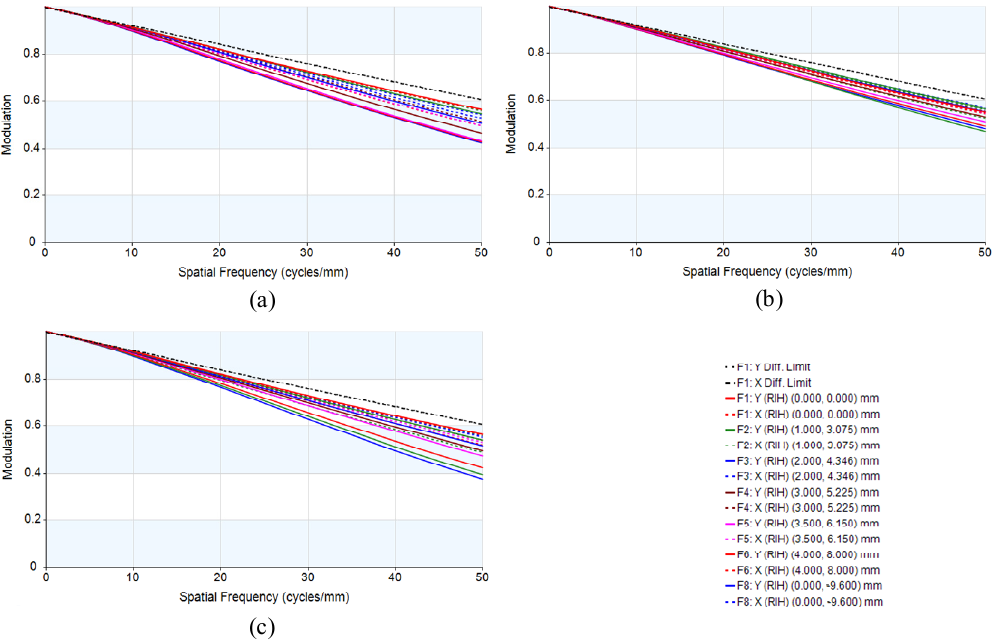
Figure 6. Corresponding MTF performance of the zoom lens at focal length: ( a ) 100 mm; ( b ) 250 mm; and ( c ) 400 mm.